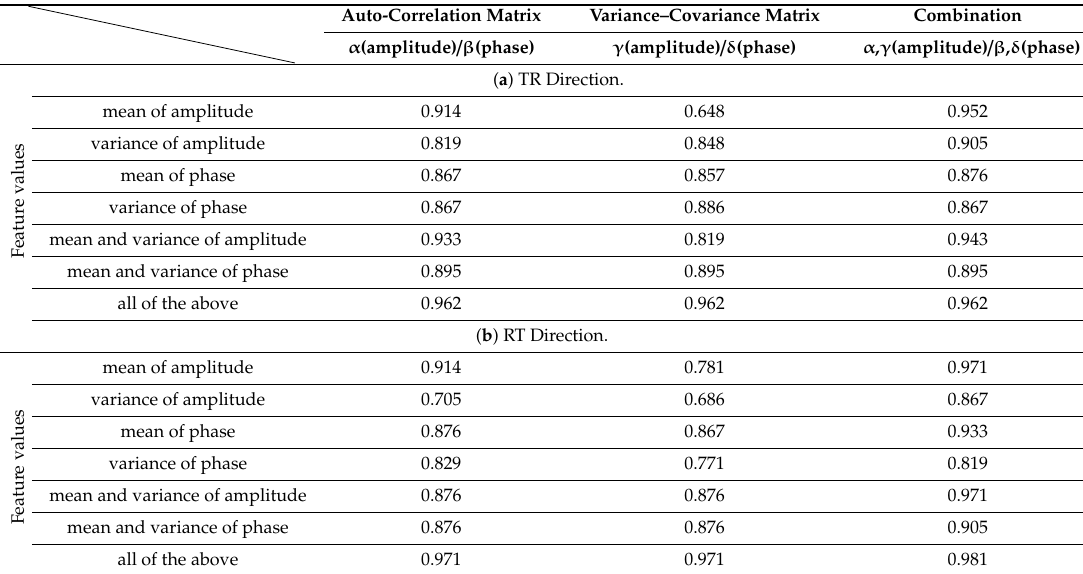
Table 1. Prediction accuracy when using only the CSI (without the length of the final passing section). The values denote the predicted